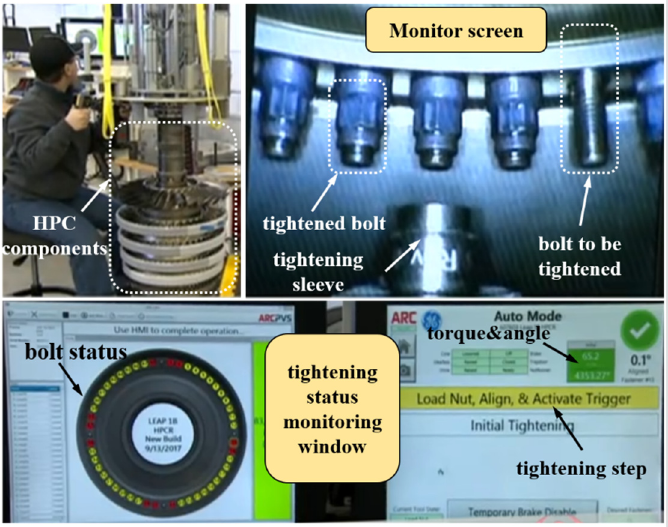
Figure 23. Semi-automated tightening equipment used for the rotor of the high-pressure compressor of the US LEAP-1B aeroengine [96].